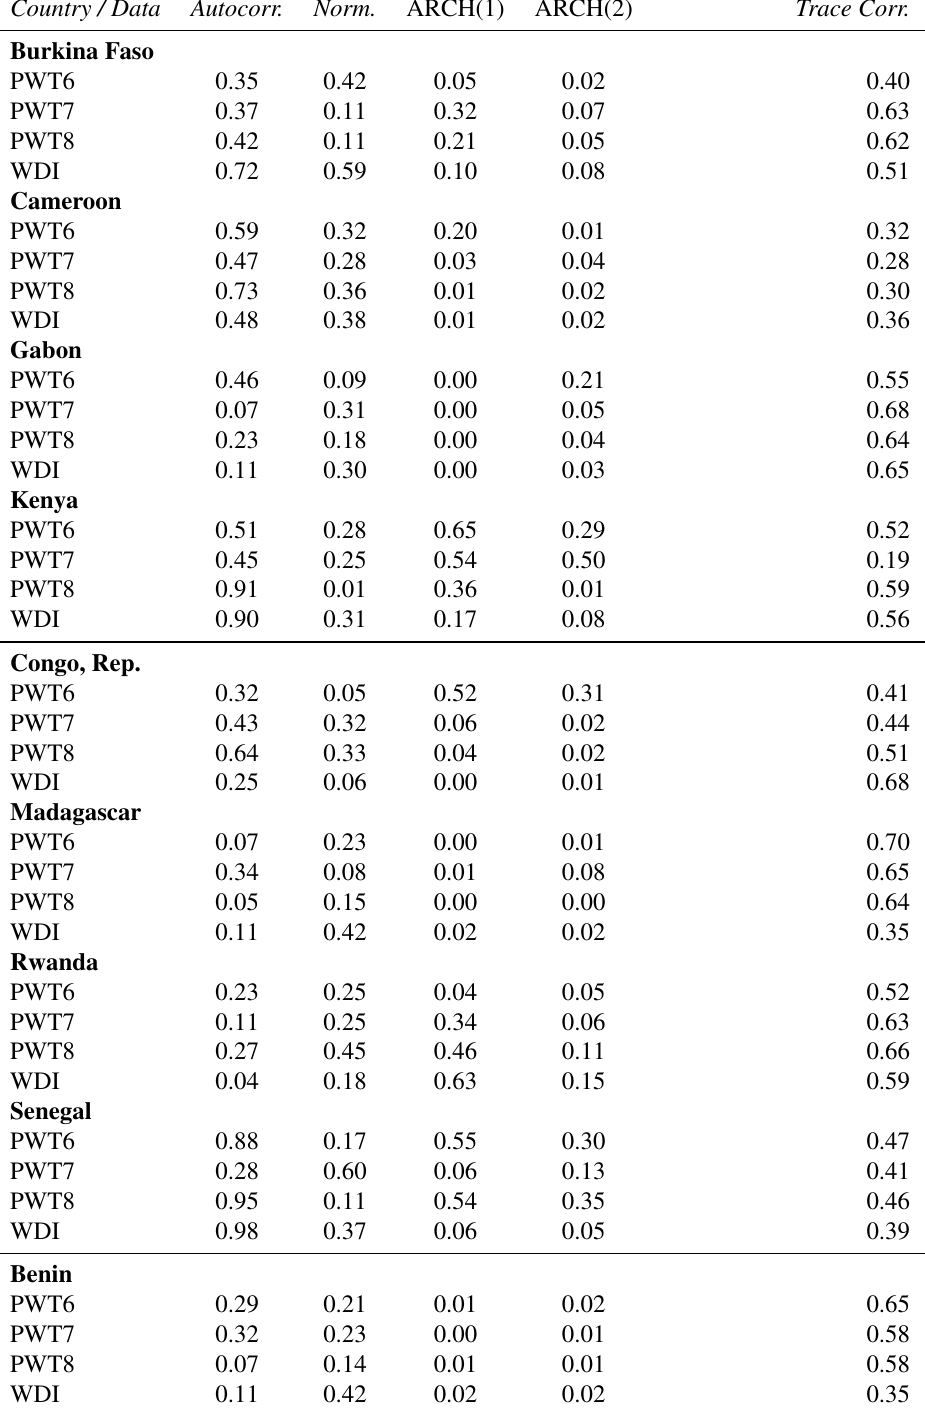
Table 7: Misspecification